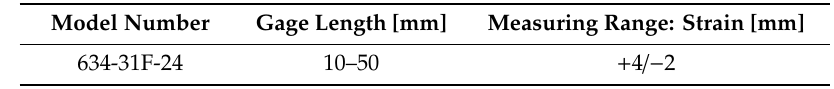
Table 5. Technical characteristics of the extensometer used in the 3D printing specimen experimental tests.